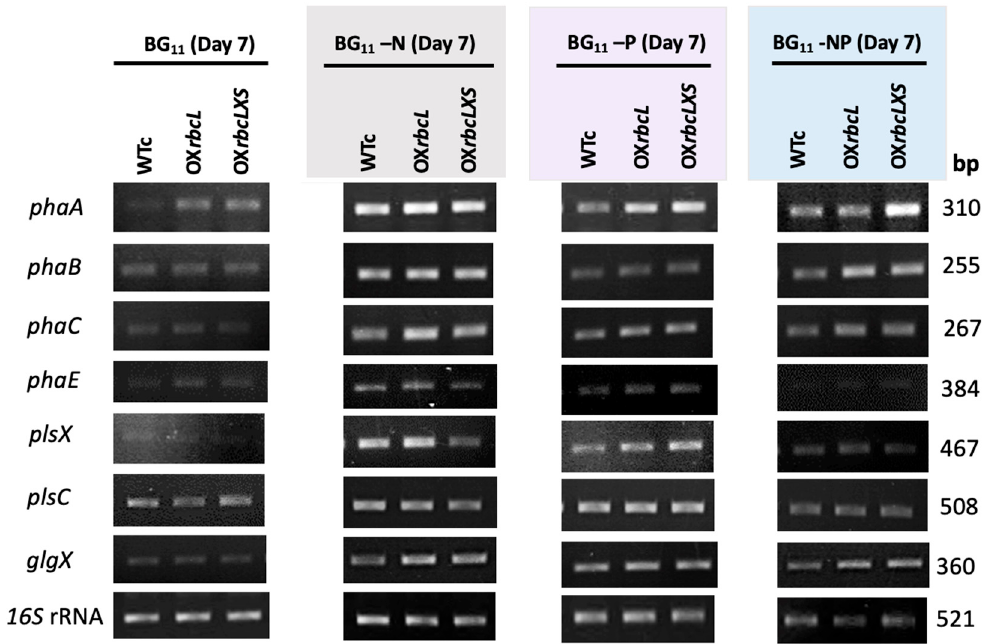
Figure 8. Relative transcript levels of phaA , phaB , phaC , phaE , plsX , plsC , and glgX performed by RT- PCR in Synechocystis WTc, OX rbcL , and OX rbcLXS strains after adapting in normal BG 11 medium, BG 11 -N, BG 11 -P, and BG 11 -NP for 7 days. The 16s rRNA was used as reference control. The band intensity data were shown in Supplementary Information Table S2. All cropped gels were taken from the original images of RT-PCR products on agarose gels as shown in Supplementary Infor- mation Figure S3).